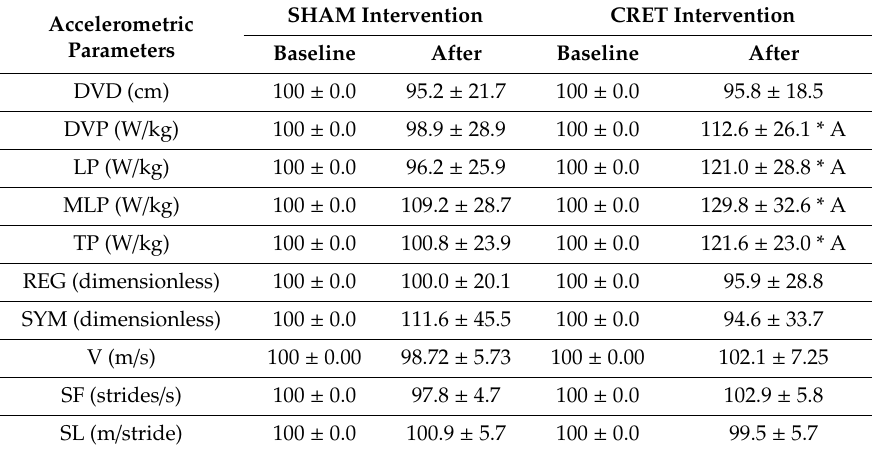
Table 4. Mean values of the accelerometric parameters measured at walk and with the accelerometer fixed at the sternum region, before and after the intervention (SHAM group and capacitive resistive electric transfer therapy group (CRET)). Data are expressed as the mean percentage ± SD, relative to baseline